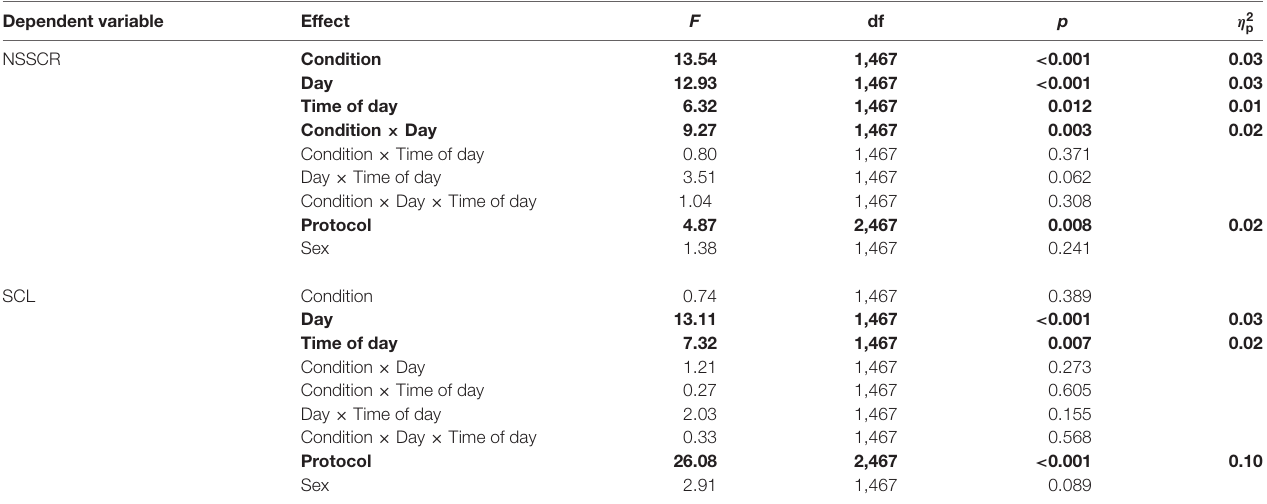
TABLE 4 | Mixed-effects ANOVAs for frequency of NSSCR and